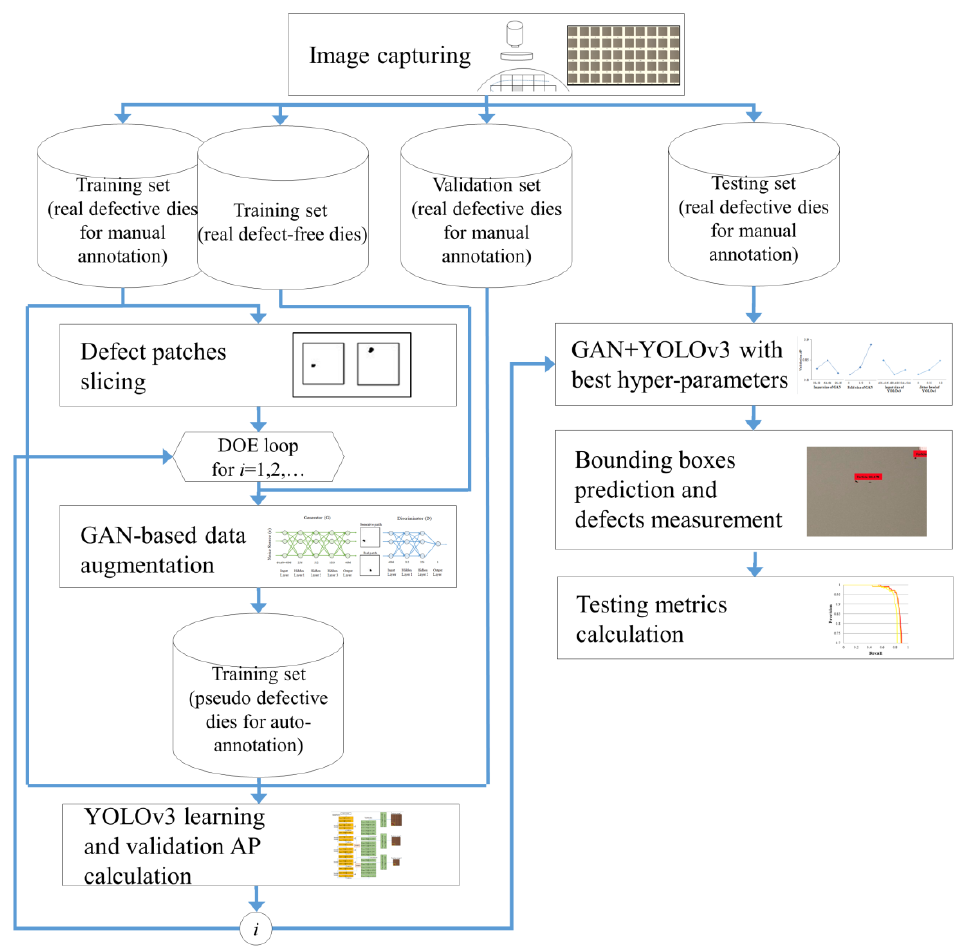
Figure 1. The research process.